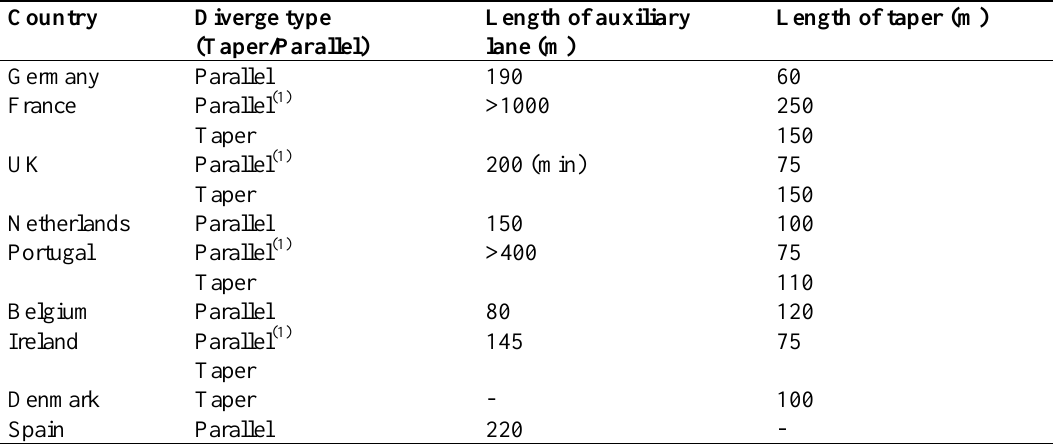
Table 5. Recommended geometric parameters for selected EU countries Country Diverge type Length of (Taper/Parallel)